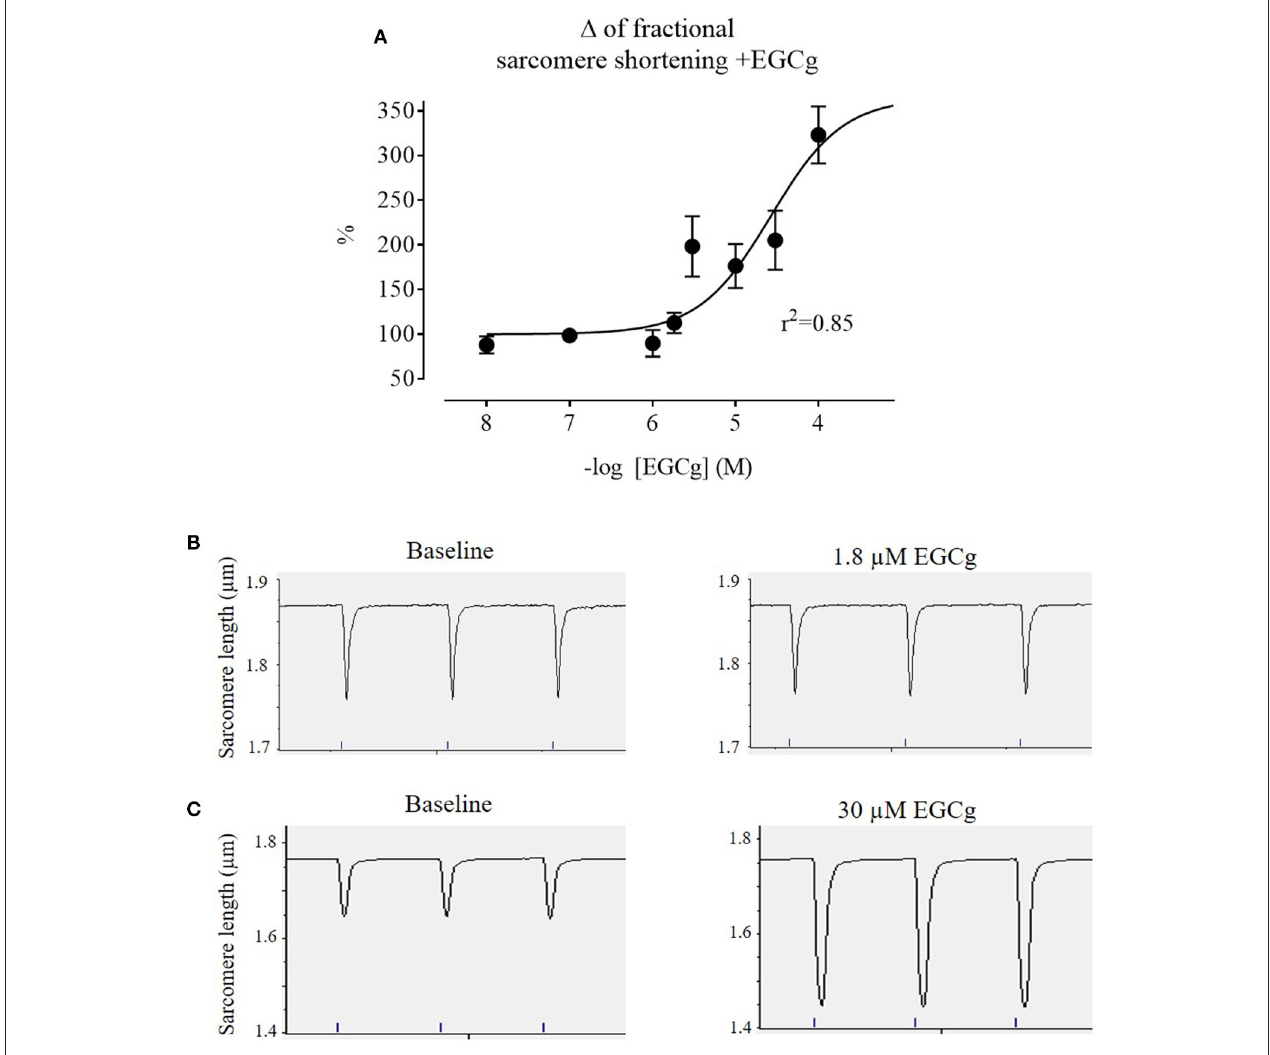
FIGURE 1 | EGCg effect on Mybpc3 WT cardiac myocyte contractility. (A) After isolation of ventricular myocytes from adult Mybpc3 WT mice, paired (before/after EGCg) concentration-response curves were performed. Graph depicts % of fractional sarcomere shortening as readout with increasing EGCg concentrations (10 − 8 = 100 nM, 10 − 7 = 10 nM, 10 − 6 = 1 µ M, 10 − 5.74 = 1.8 µ M, 10 − 5.52 = 3 µ M, 10 − 5 = 10 µ M, 10 − 4.52 = 30 µ M, 10 − 4 = 100 µ M; n